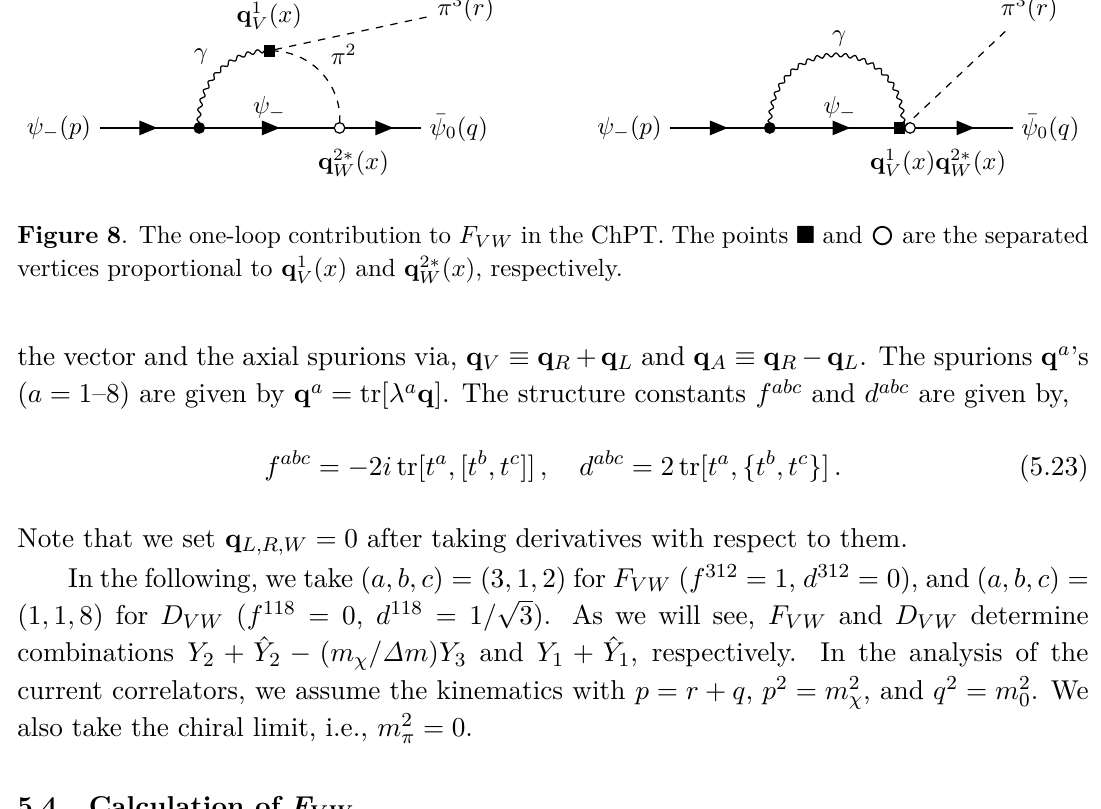
Figure 7 . The tree-level contribution to F V W in the ChPT. The point (cid:4) to q 1 ( x ) q 2 ∗ ( x ) . V W